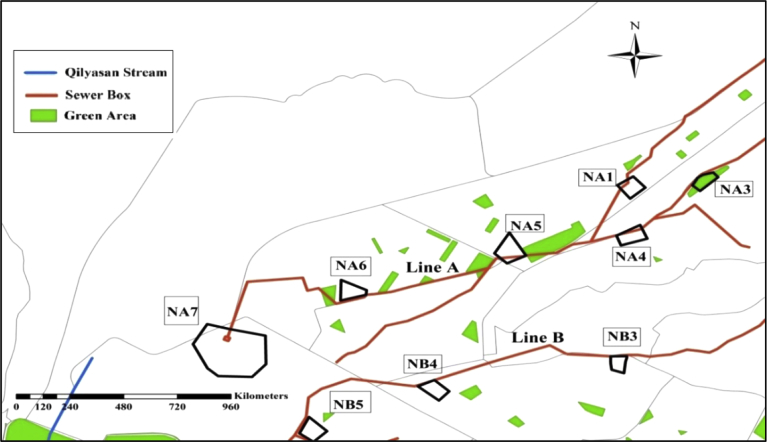
Nominated Areas on Line A and part of Line B.